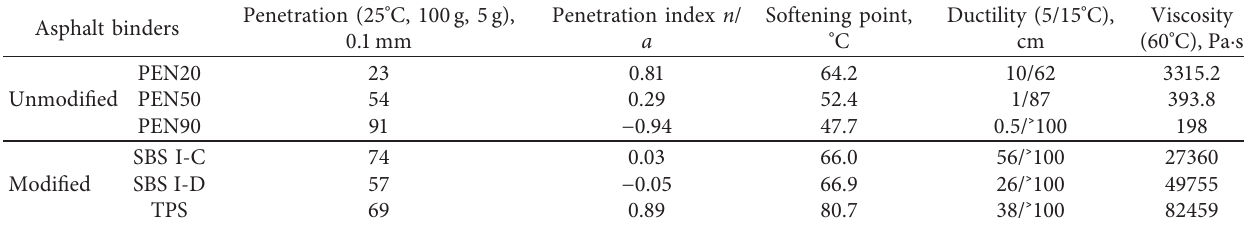
Table 1: The basic physical properties of six asphalt binders.